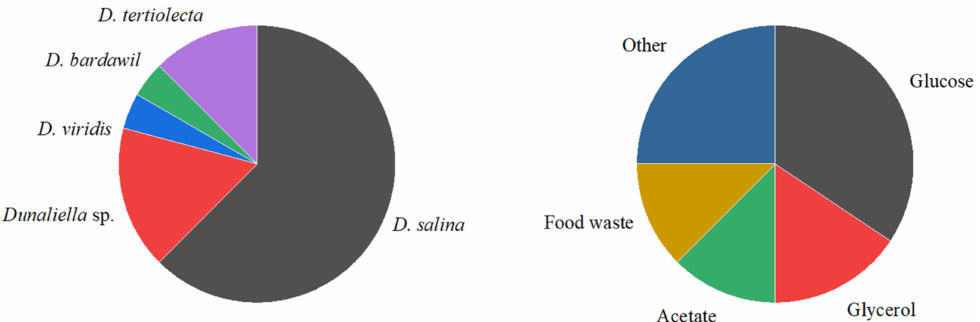
Figure 1. Distribution of papers on the platforms Scopus and Web of Science (1996–2022) regarding the use of different species of Dunaliella ( left ) and organic carbon sources ( right ) [14,16,24,29–46]. References were collected on 25 February